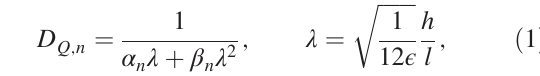
) on Q for samples l 0 . 6 , and 20 nm thickness. l ¼